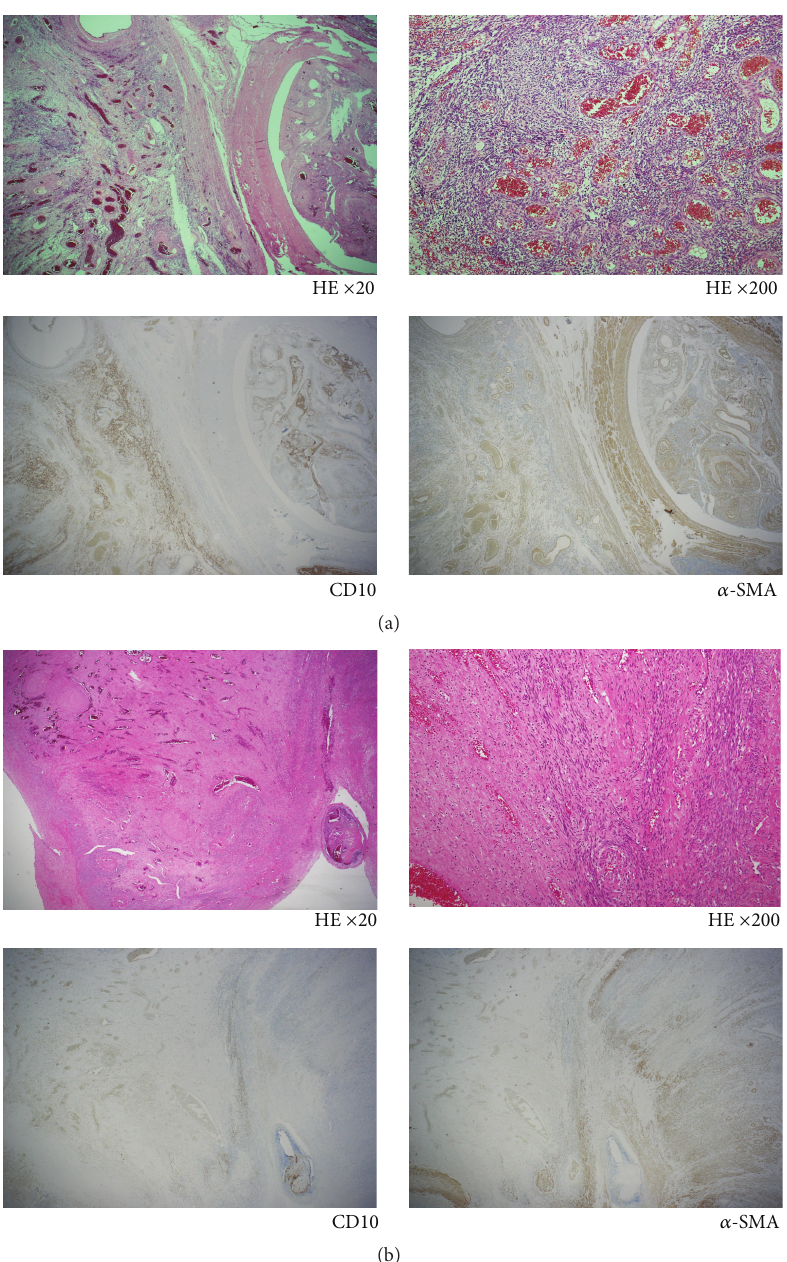
Figure 5: (a) Histopathological and immunohistochemical analyses show low-grade endometrial stromal sarcoma. The primary tumor in the uterus comprises CD10-positive short spindle cells resembling the stromal cells of proliferative endometrial tissue. Also spindle cells with abundant cytoplasm and ellipsoidal nuclei ( 𝛼 -SMA-positive cells) are mixed with the tumor cells. (b) The intracardiac tumor shows extensive smooth muscle differentiation. Main part is occupied with the spindle cells ( 𝛼 -SMA-positive). Scattered aggregates of small darker cells (CD10-positive) are still